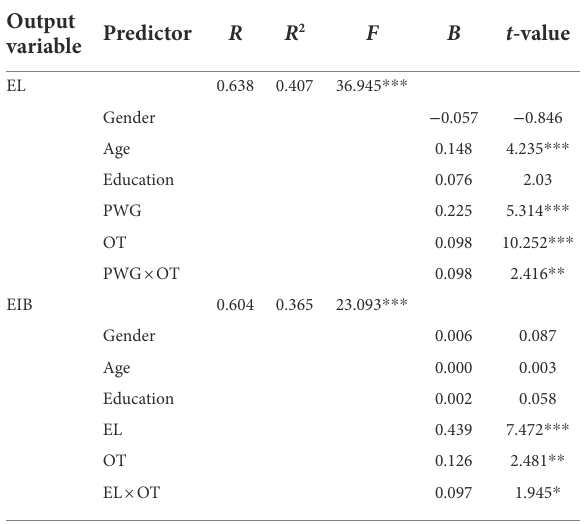
TABLE 6 Test of moderating